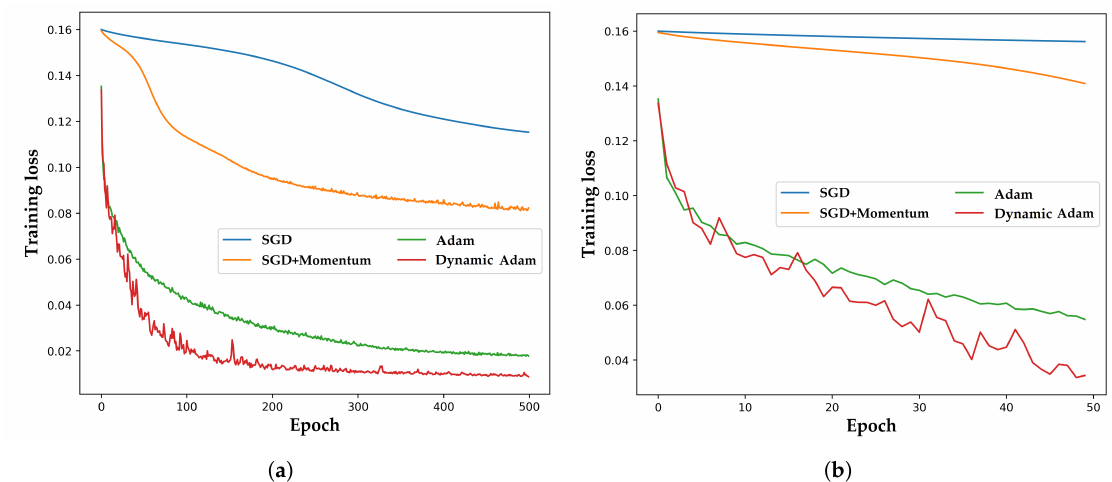
Figure 9. Training loss of different optimization algorithms: ( a ) integral convergence comparison; and ( b ) initial training loss.